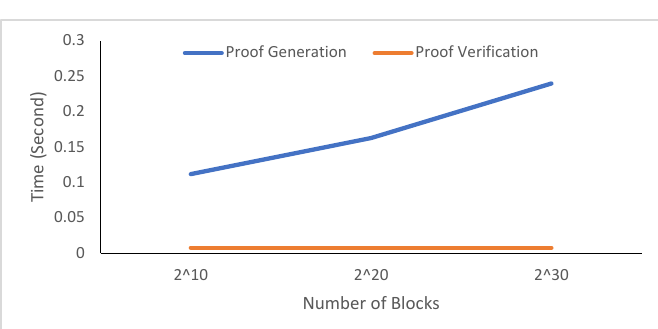
Figure 5. Preliminary experimental results of the block verification protocol using a low end Celeron